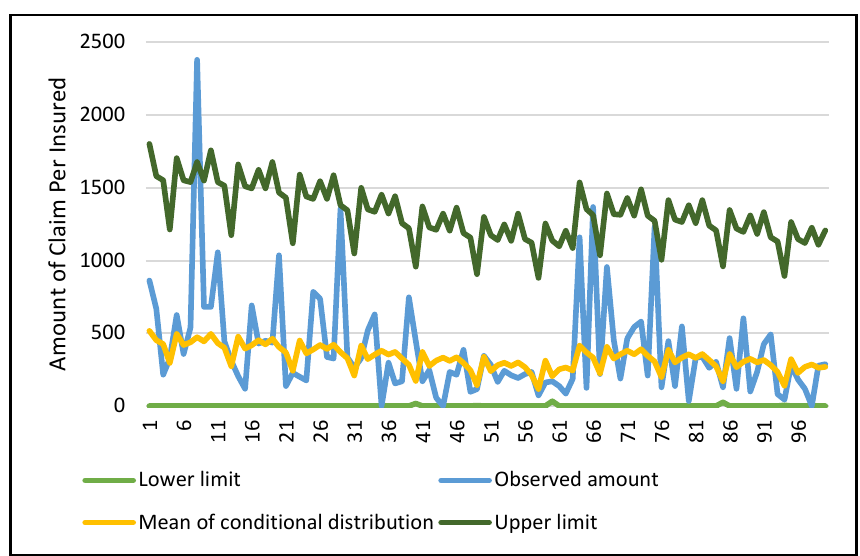
Fig. 3. Lower and upper limits of the first 100 prediction intervals for the amount of claim per insured ( 𝛼 = 0.05 , in-sample prediction).